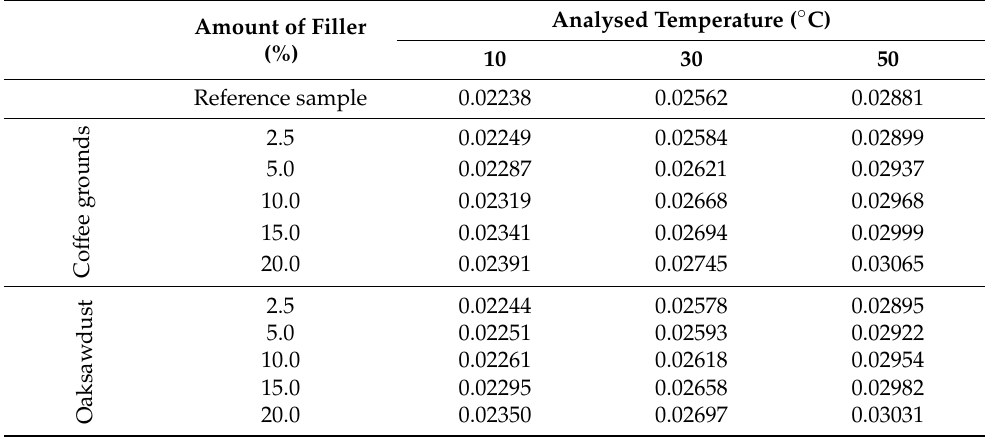
Table 3. Results of the thermal conductivity coefficient (W/m · K) for the reference sample and composites with coffee grounds and oak